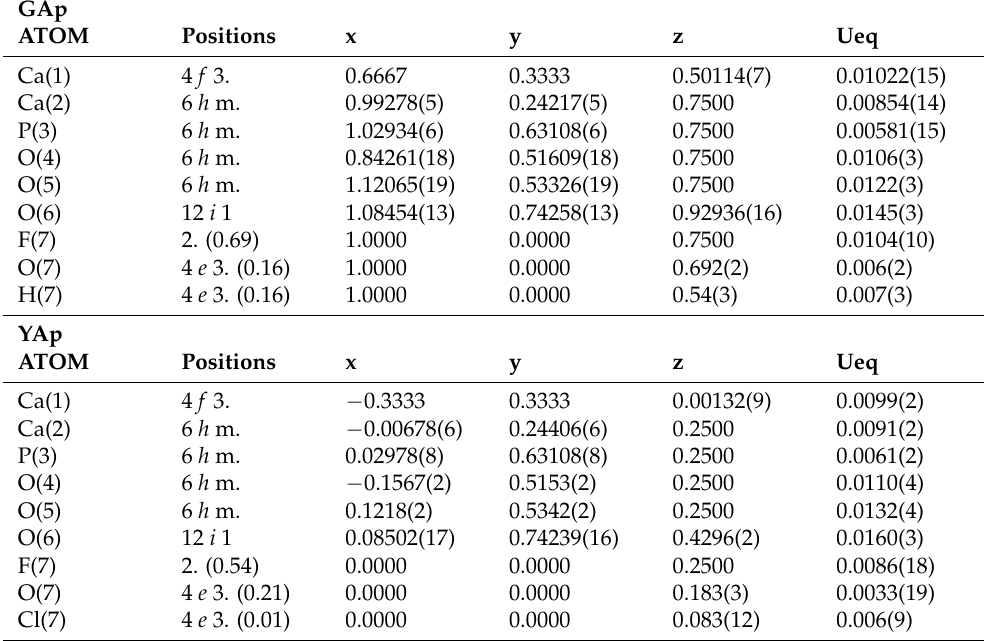
Table A3. Fractional atomic parameters x, y, z and equivalent displacement parameters Ueq (Å 2 ) de-